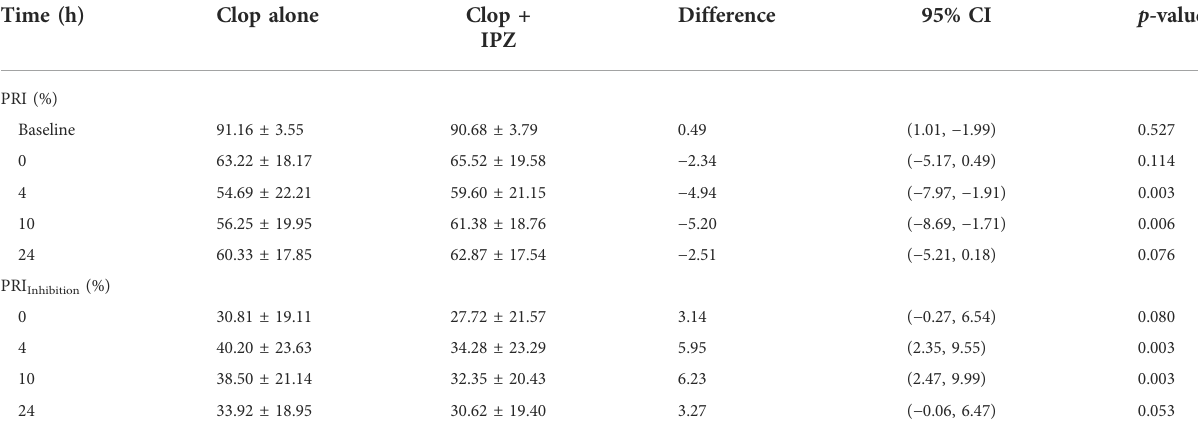
TABLE 3 PRI and PRI Inhibition by VASP P2Y 12 assay in subjects under clopidogrel treatment with or without ilaprazole.